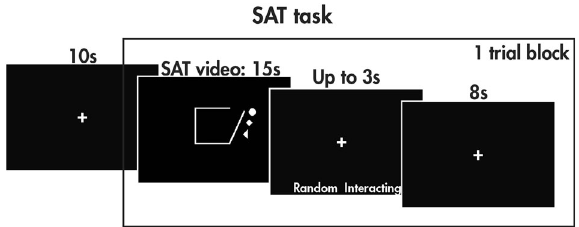
Fig. 1 The Social Attribution Task (SAT). The SAT task consisted of trial blocks with a social or random video (15 s), a prompt asking the participant about the nature of the video (random or interacting, up to 3 s long depending on response time), and a rest period (8 s). Each run consisted of an initial ten-second rest period to acclimate the participant to the scanning environment, followed by eight trial blocks with two social help, two social threat, and four random videos presented in a randomised order; a total of three runs were